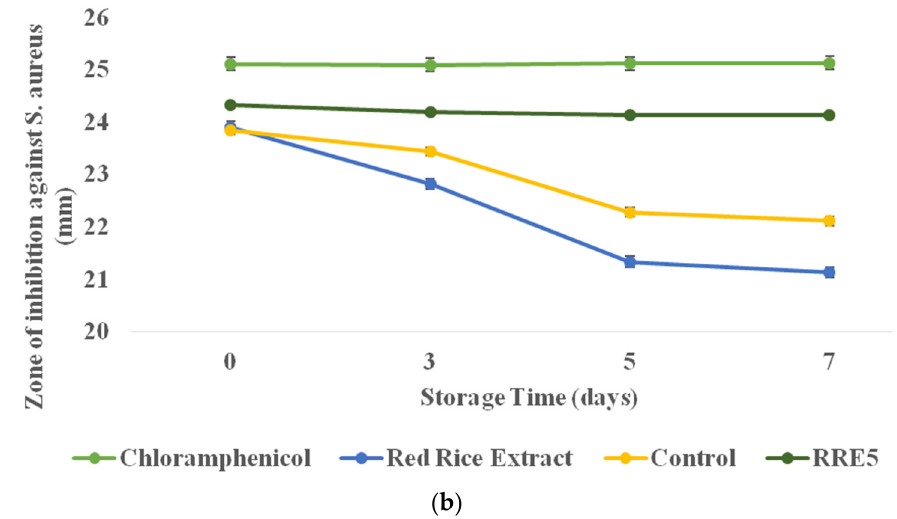
Figure 10. Effect of storage time (7 days) on the antimicrobial efficacy of red rice extract, control, and RRE5 nanoemulsion against ( a ) Escherichia coli , ( b ) Staphylococcus aureus. Data are presented as means ± SD ( n = 3).